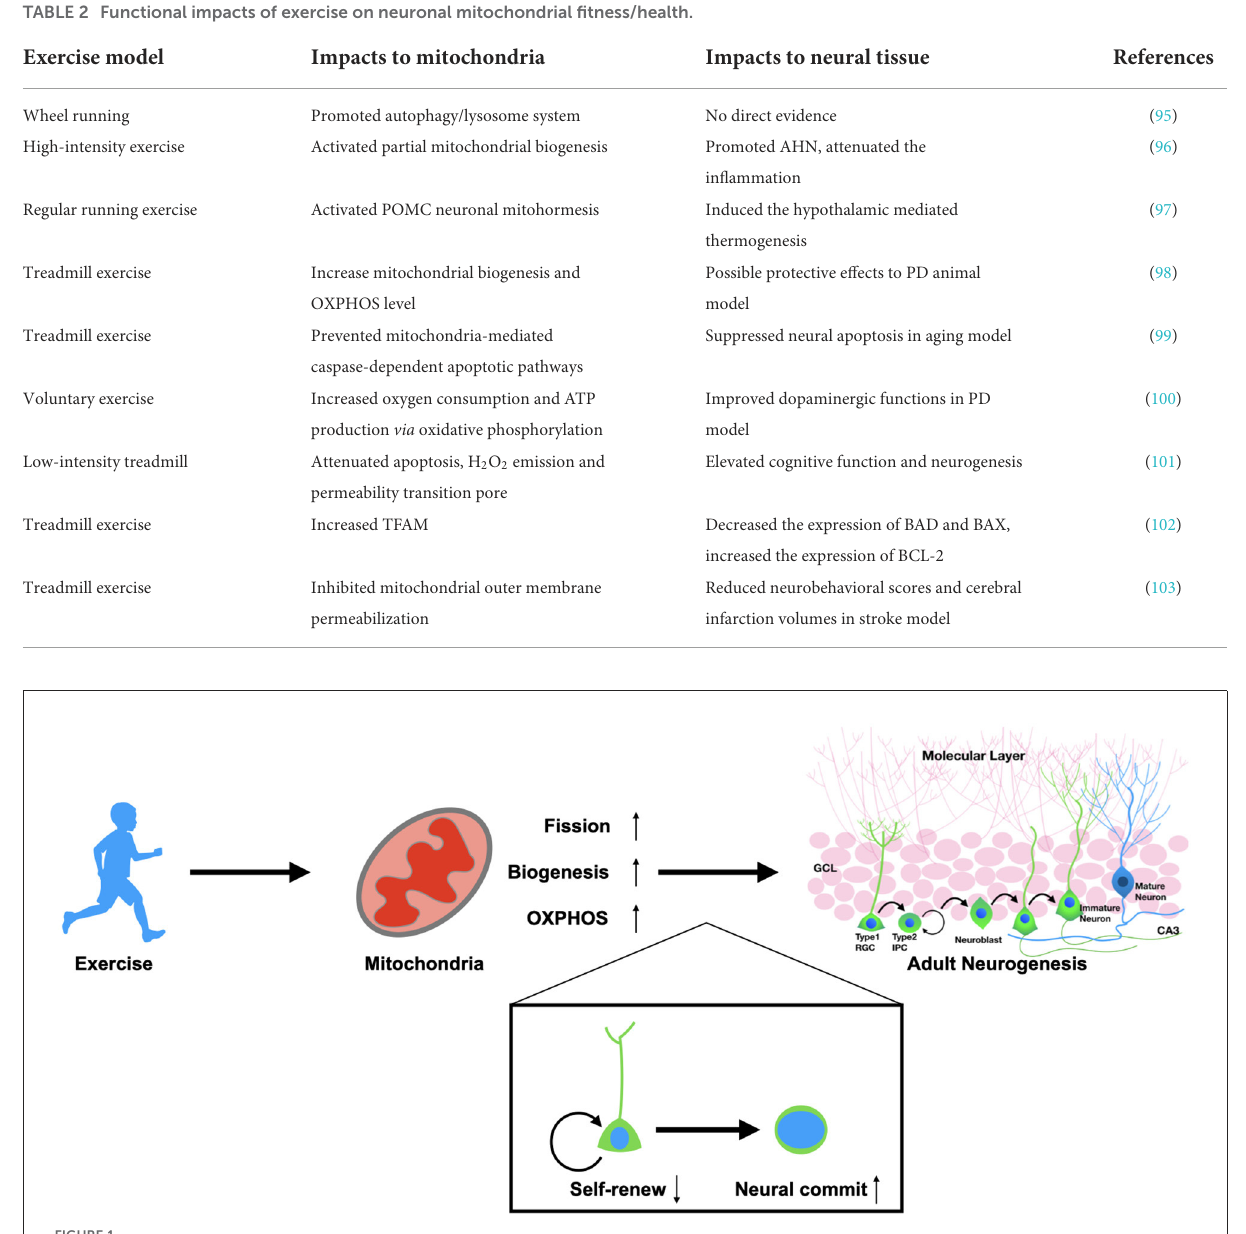
FIGURE1 Exercise promotes adult neurogenesis via mitochondria. Physical exercise could enhance mitochondrial functions in adult neural stem cells. Exercise promotes the fission of mitochondria, biogenesis, and OXPHOS metabolism. These alterations result in the fate determination of NSCs from self-renewal to neural commitment, which thereby promotes adult neurogenesis in both physiological and pathological